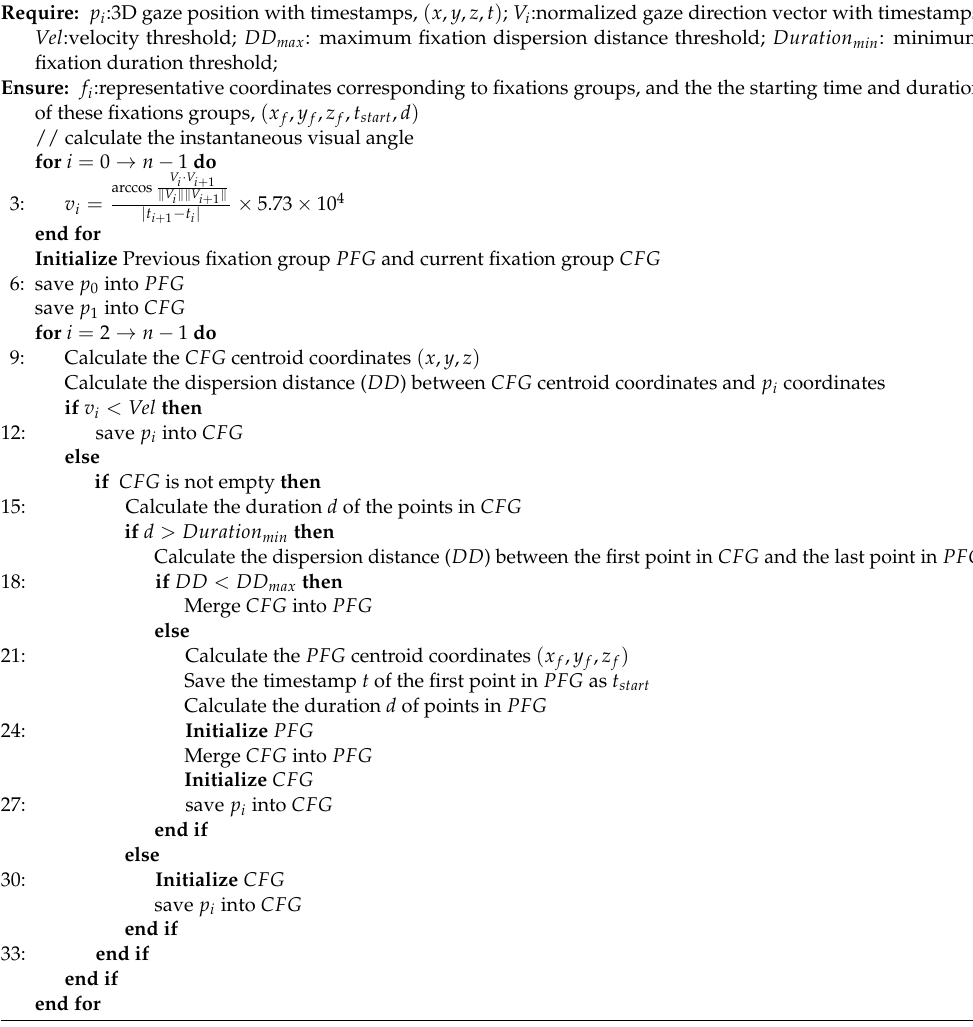
Algorithm A1 Velocity and Dispersion-Threshold